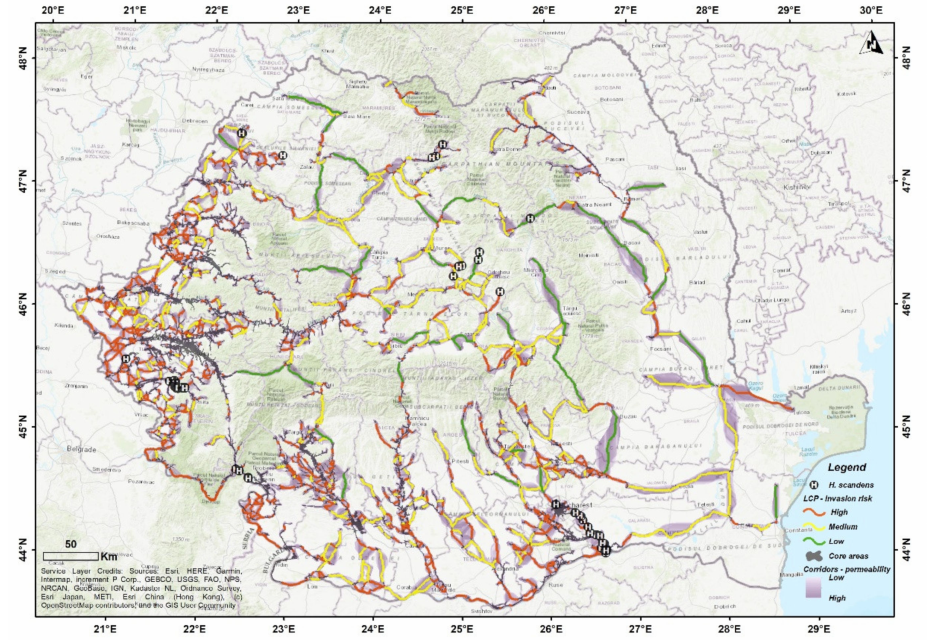
Figure 2. Habitat connectivity analysis and invasion risk of H. scandens in